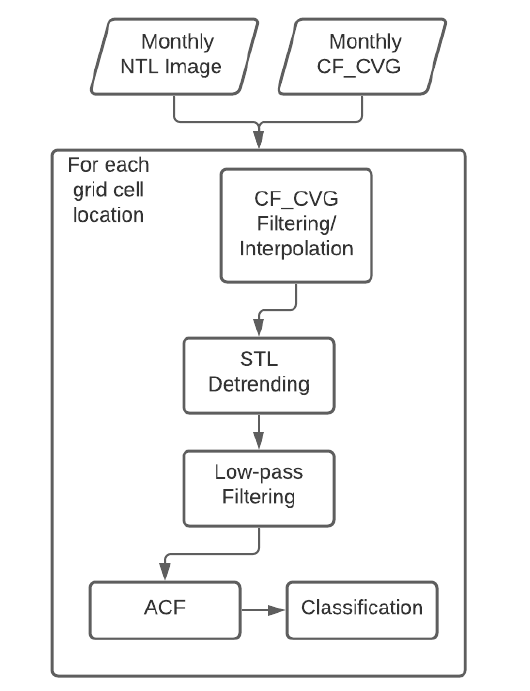
Figure 5. Flowchart of VNL image processing. SNL, Seasonal decomposition of Time series by